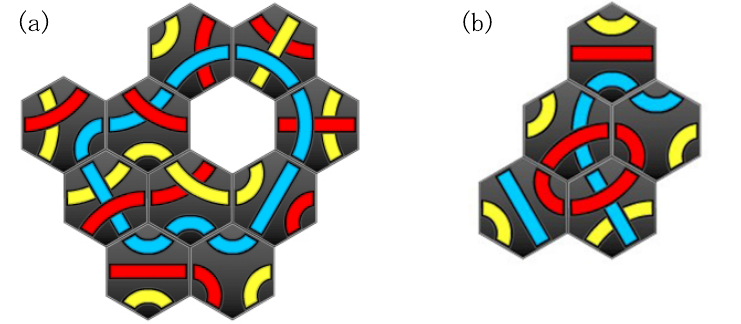
Figure 2. Examples of “uncleared” arrangements although they satisfy rules from 1 to